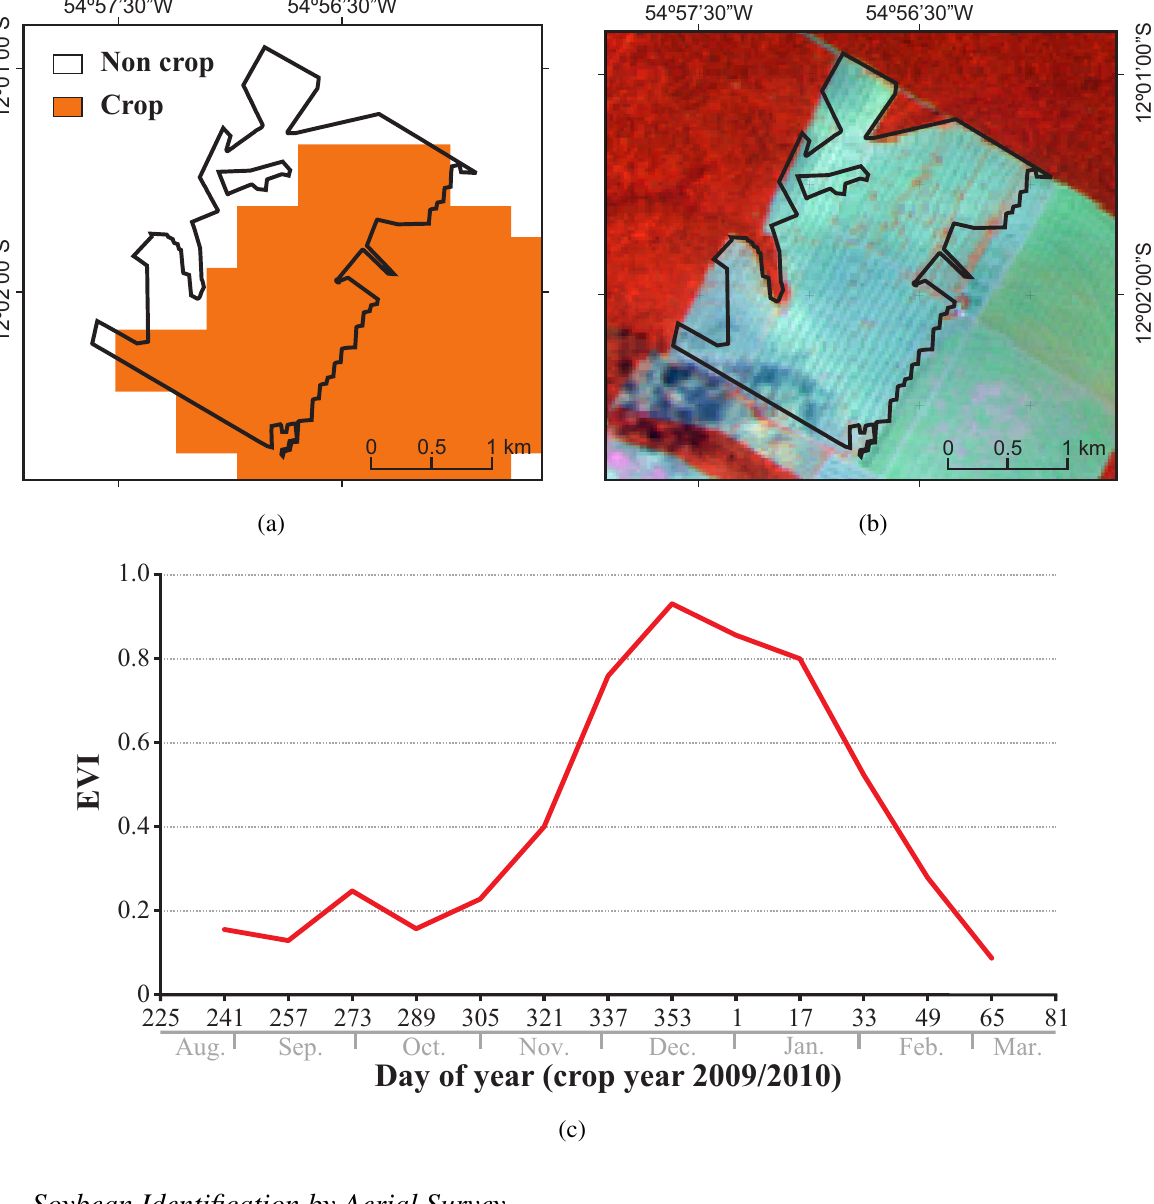
Figure 4. Example of a polygon selection procedure: (a) limit of polygon ID 6220 overlaid on the classification result of MODIS images; (b) polygon overlaid on the TM image from 25th October 2010 of path 226 row 68 (color composition 4R5G3B); (c) EVI temporal profile referring to the central pixel of the